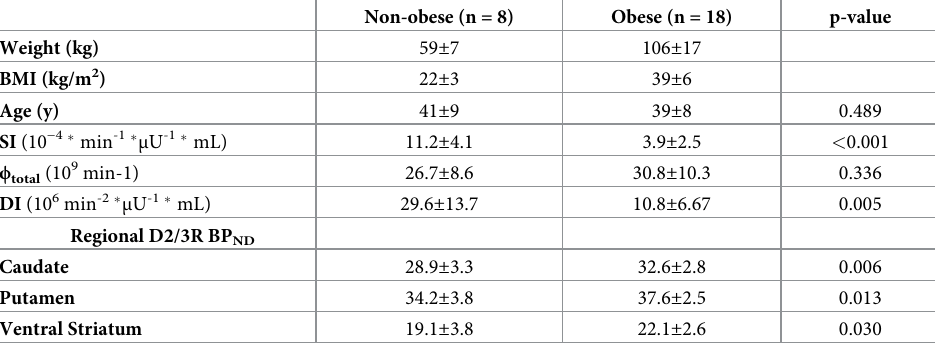
Table 1. Total cohort of participants that completed baseline PET imaging and